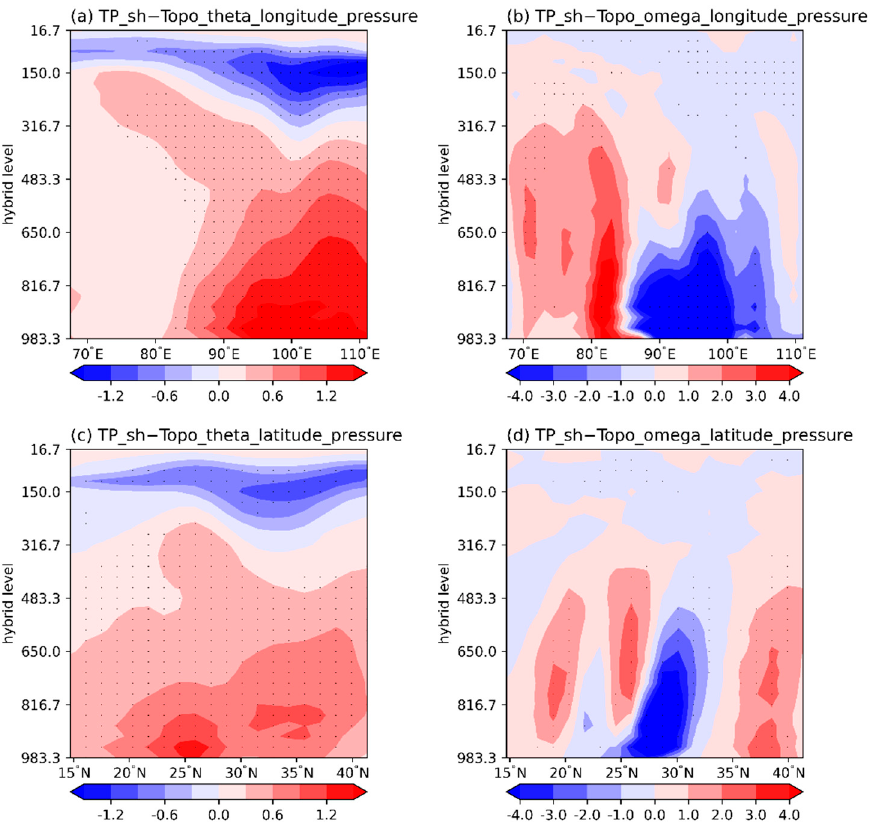
Figure 7. The differences in hybrid level − longitude averaged from 24.5° N–30.1° N ( a , b ) and hybrid level–latitude averaged from 80.2° E–98.4° E ( c , d ) cross-sections of potential temperature (( a , c ), unit: K) and vertical velocity (( b , d ), unit: 0.01 Pa/s) between the TP_sh and Topo tests. Dots denote values exceeding the 95% confidence level of Student’s t test.